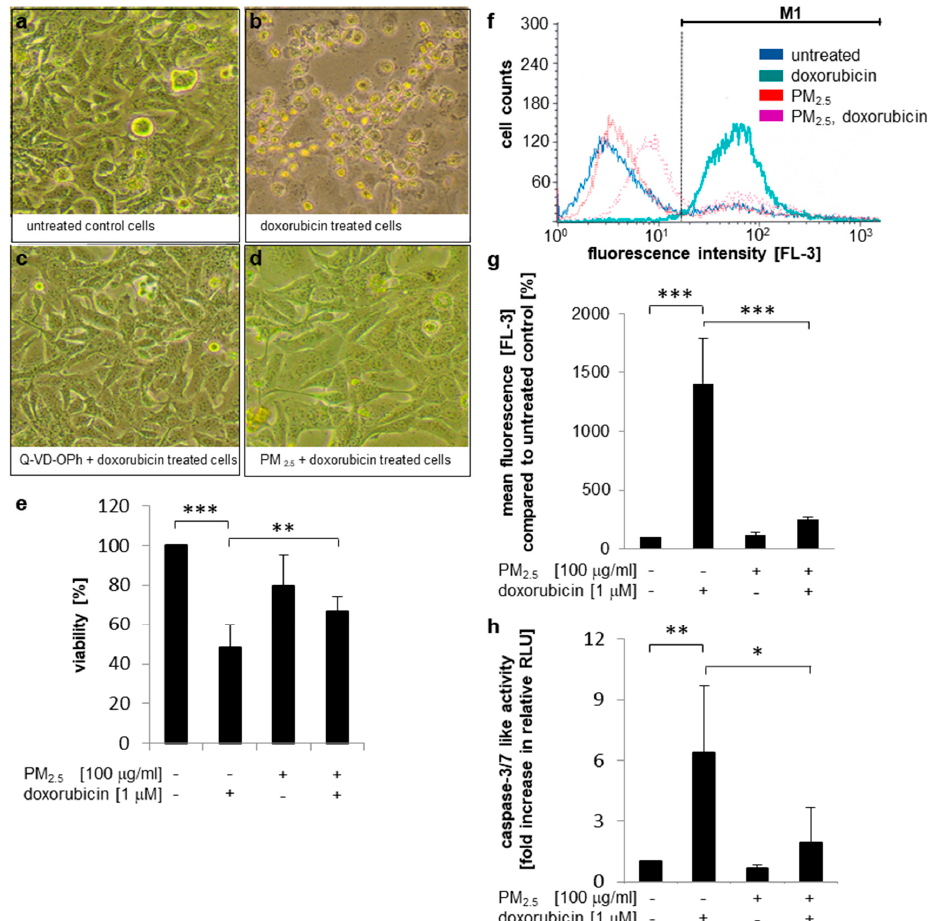
Figure 5. Cell death resistance to doxorubicin mediated by PM 2.5 . BEAS-2B cells were cultured in the presence of 100 µ g / mL PM 2.5 for 3 to 5 weeks, before final passage and re-exposure of cells to 100 µ g / mL PM 2.5 for 48 h. Q-VD-OPh (10 µ M) or API-2 (5 µ M) were added 1 h prior to the last PM 2.5 exposure, doxorubicin (1 µ M) was added 24 h after the last addition of PM 2.5 . Equally cultured cells that were never exposed to PM 2.5 served as controls. ( a – d ) Photomicrographs of BEAS-2B cells. ( e ) Cell viability determination by an MTT assay (n = 3. ( f , g ) Quantification of the intracellular doxorubicin content by flow cytometry. In ( f ), a representative histogram is shown using the FL3 detector, ( g ) depicts mean fluorescence values (FL3) compared to untreated cells (n = 4). M1: gated region for measurement of mean fluorescence. ( h ), detection of apoptosis by a caspase 3/7 activity assay (n = 6). RLU: relative light units. Values are depicted as means and +standard deviations; * p < 0.05; ** p < 0.01; *** p < 0.001.